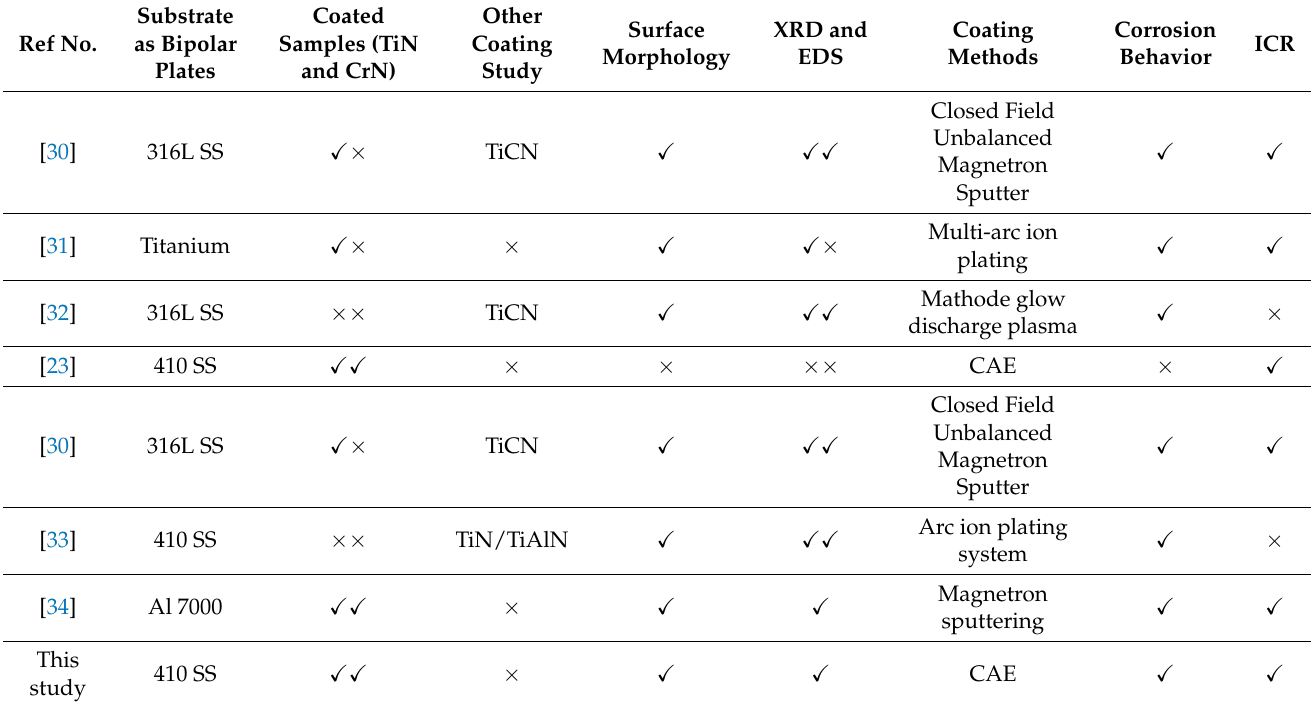
Table 1. Characteristics of CrN and TiN coatings used for BPPs in fuel